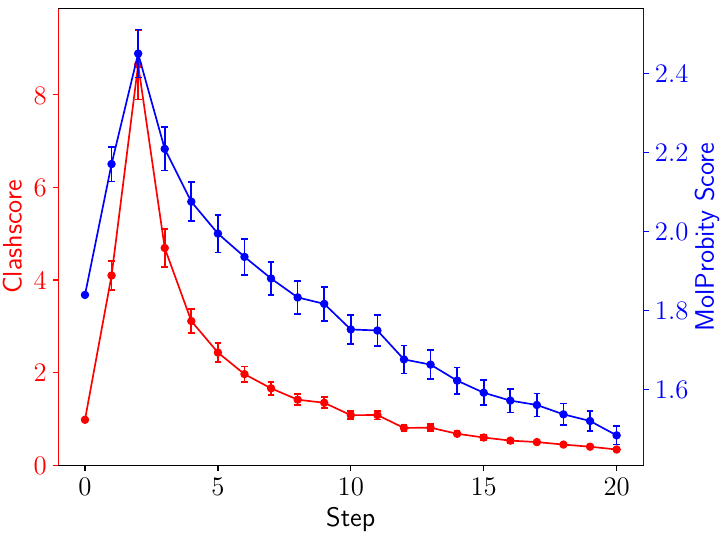
Figure 9. Clash (red, left axis) and MolProbity (blue, right axis) scores [50] for asymmetric units in the ChAdOx1 virus capsid. Scores are computed for individual asymmetric units within the facet and then averaged, with the uncertainties representing the standard error computed from among the different asymmetric units. The clashscore and the overall MolProbity score increase after the initial step as the long bond traverses out of a pierced aromatic